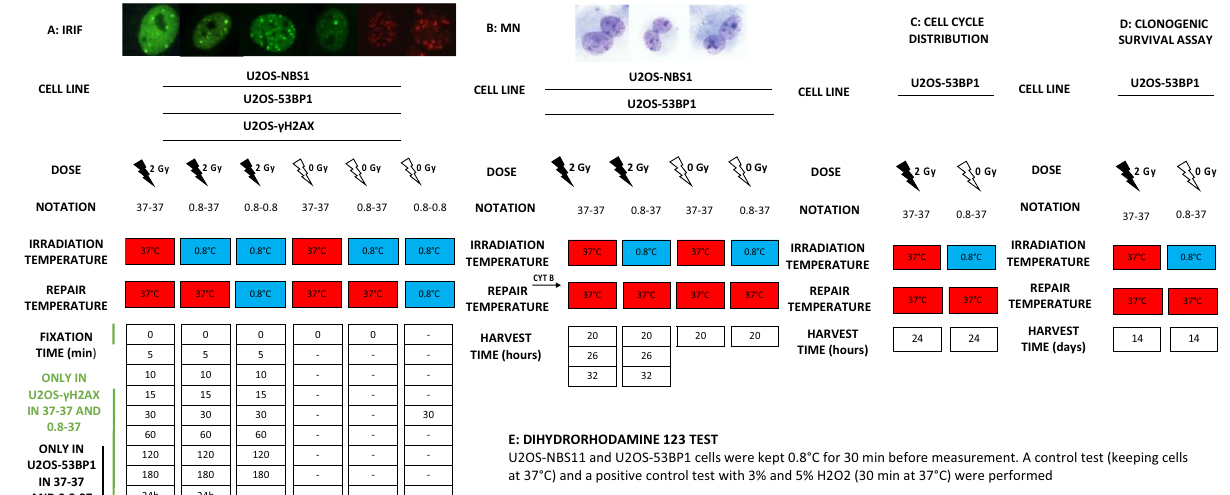
Figure 1. Scheme of the experimental setup to study IRIF ( A ), micronuclei ( B ) in U2OS-NBS1 and U2OS- 53BP1 cells, distribution of cells in the cell cycle ( C ), clonogenic survival assay ( D ) and oxidative stress assay ( E ) in U2OS-53BP1 cells. Images show representative pictures of IRIF in U2OS-53BP1 cells ( A , first two from left), U2OS-NBS1 cells ( A , next two from left), U2OS-γH2AX cells ( A , last two from left) and MN in U2OS ( B ) cells exposed to 2 Gy. IRIF after a repair time of 24 h were only analysed in U2OS-53BP1 and U2OS-γH2AX cells. MN micronuclei, IRIF ionising radiation-induced